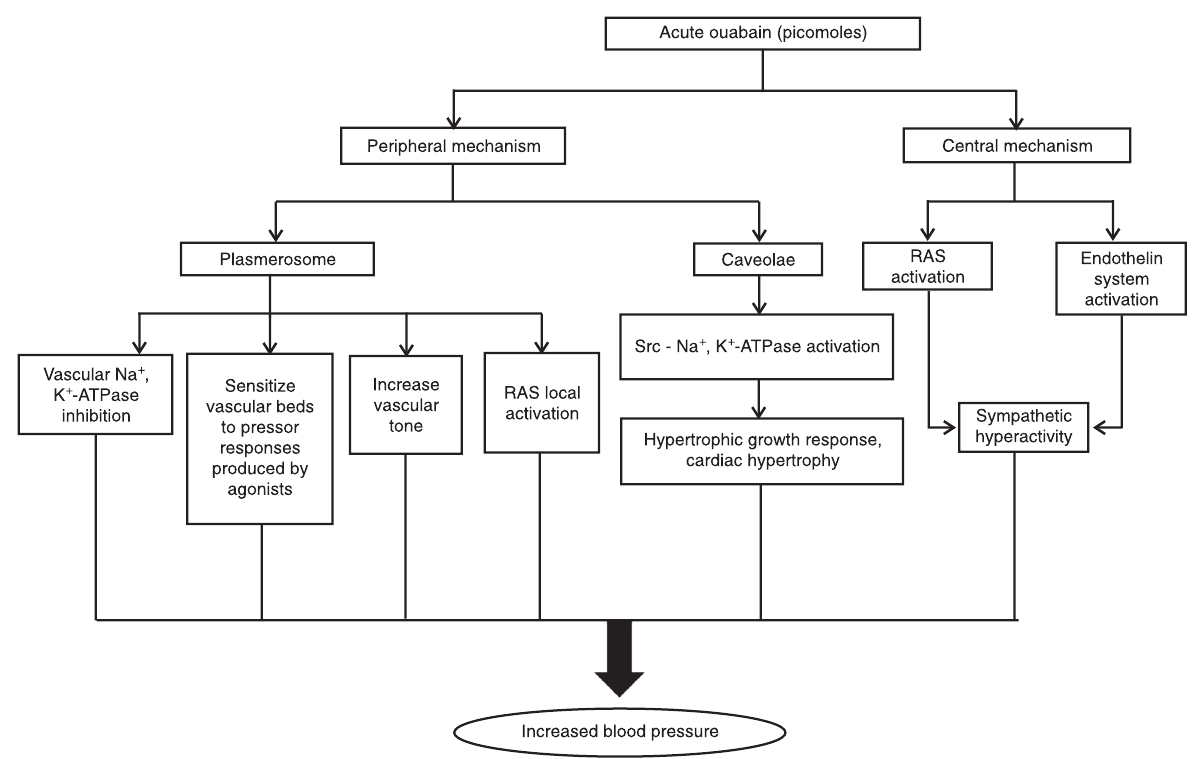
Figure 1. A generalized scheme showing the central and peripheral actions of acute ouabain. RAS = renin-angiotensin system; Src = sarcoma